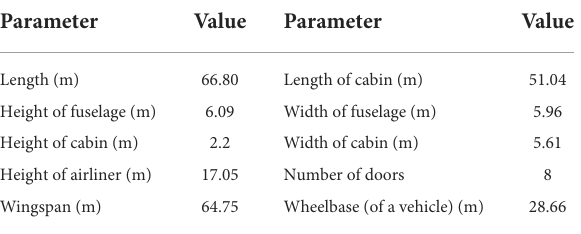
TABLE 1 Main parameters of Airbus A350-900.